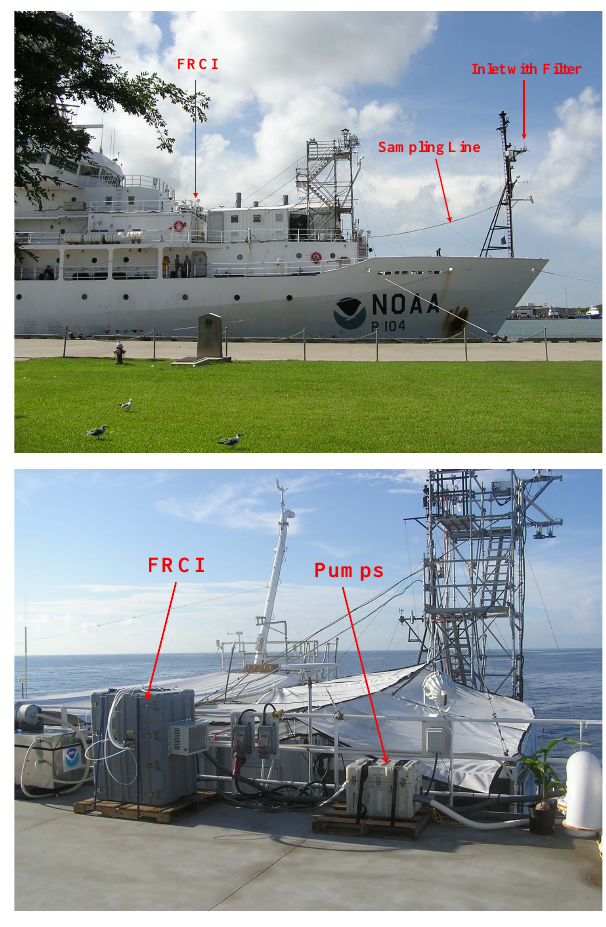
Fig. 2. Placement of the ozone measurement system during Tex- AQS and STRATUS. Upper picture: The inlet with a particle filter was located on the jackstaff near the sonic anemometer, with the sampling line running from the foremast to the ozone instrument on the deck. Bottom: The fast ozone instrument was deployed on the third deck. The large box on the pallet contained the fast re- sponse ozone chemiluminescence instrument, and the small box on the pallet to the right contained the pump